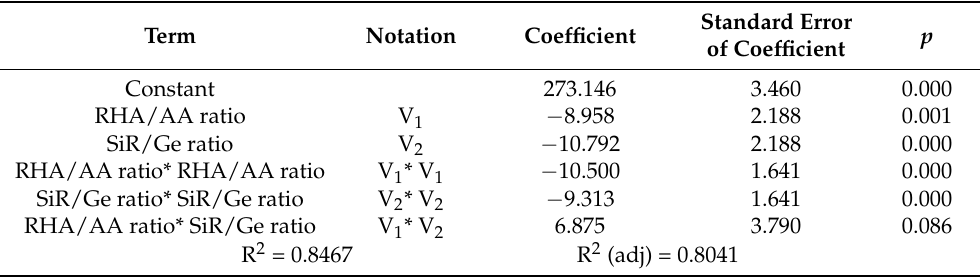
Table 7. Estimated effects and coefficient for RHA/AA and SiR/Ge ratios on the moisture absorption. Term Notation Coefficient Constant 19.031 0.257 0.000